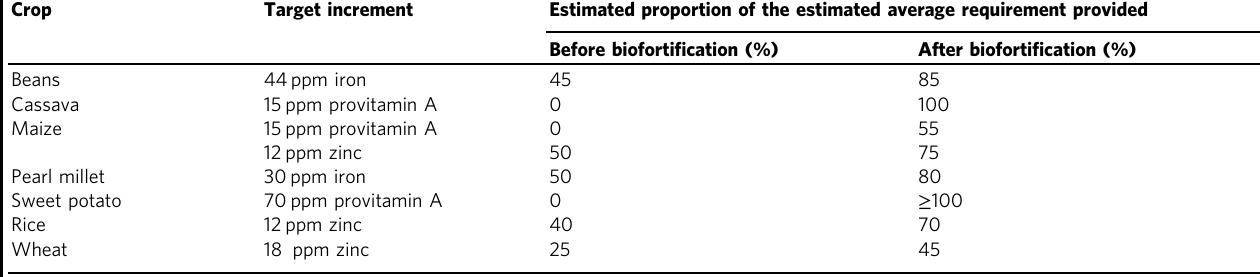
Table 1 Estimated proportion of the EAR supplied by conventionally bred bioforti fi ed crops.